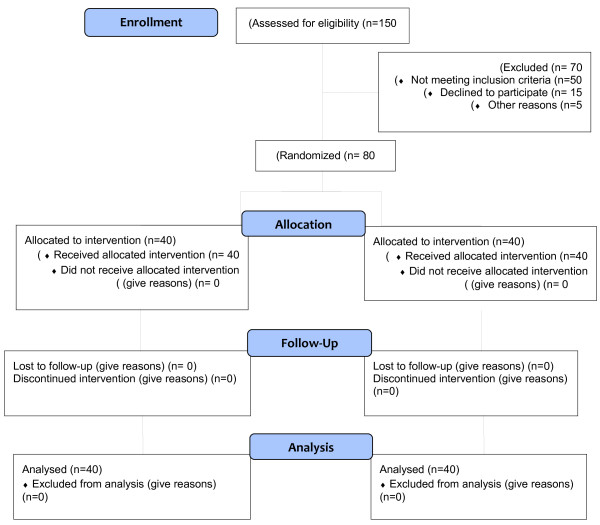
Patients’ flowchart.